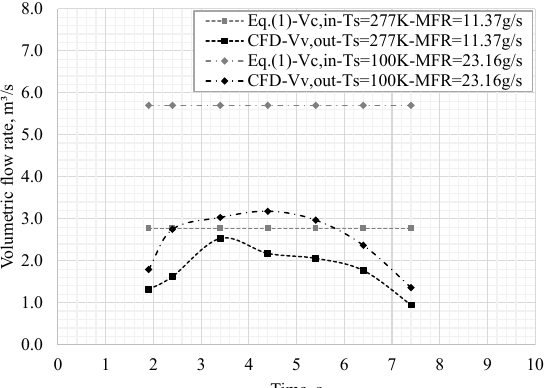
Figure 10. Effect of hydrogen storage temperature on volumetric flow rates entering and exiting the enclosure for the two limiting cases 1 (T S = 277 K) and 3 (T S = 100 K).